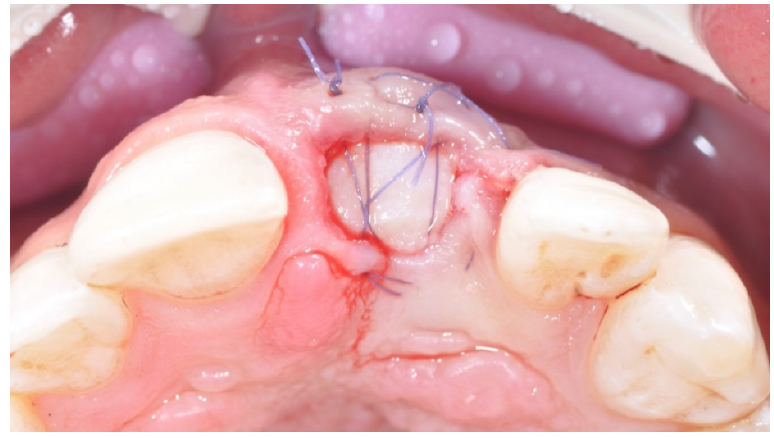
Figure 6. Tooth extraction and socket preservation with deproteinized bovine bone and CTG.